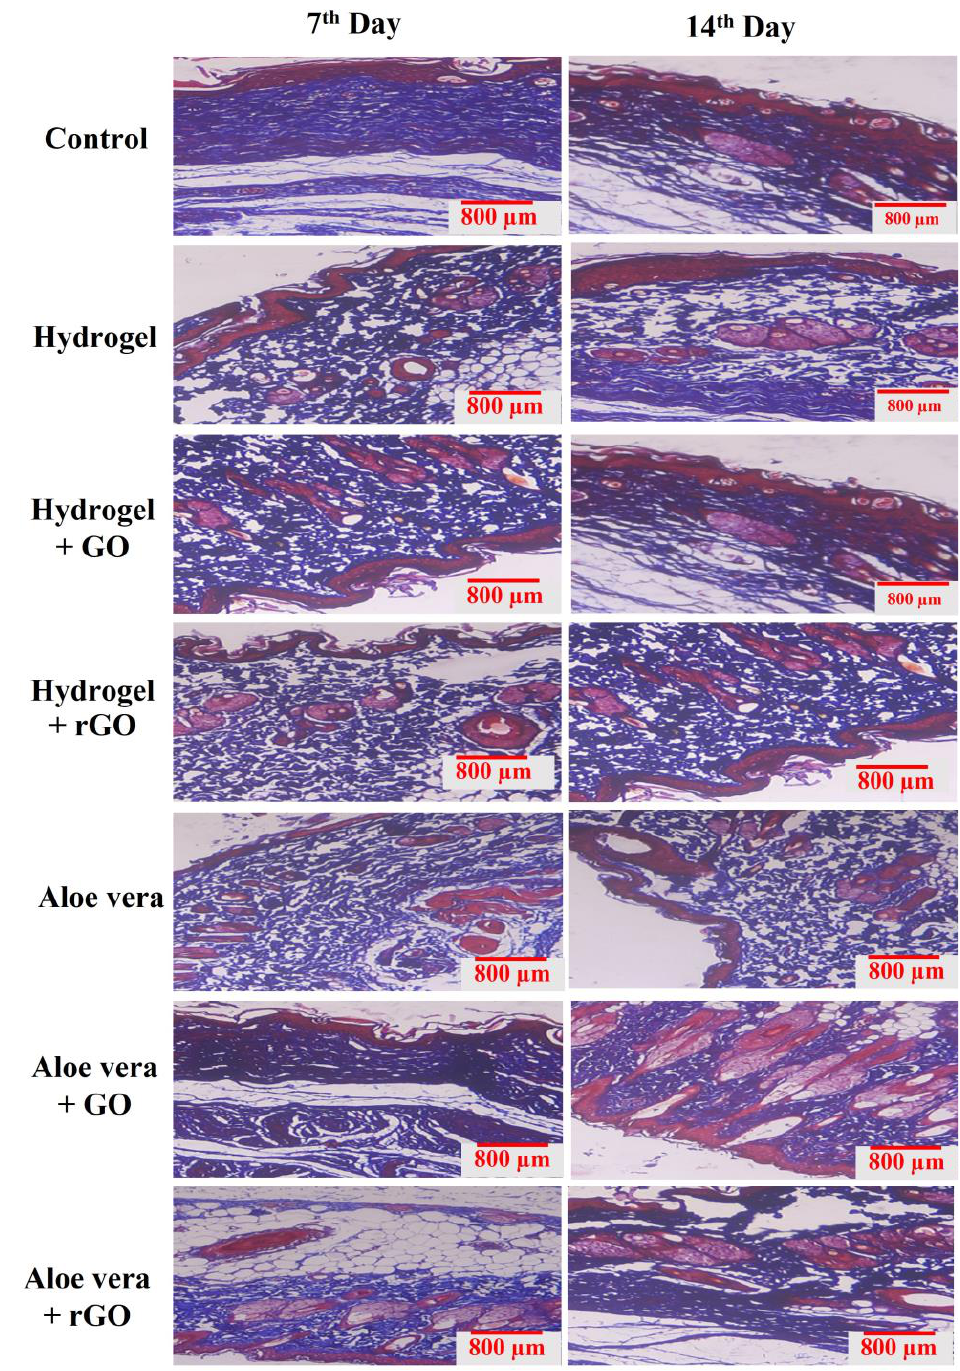
Figure 18. Masons trichome stained granulation tissues of GO and rGO-based composite gels on 7th and 15th days. The increased collagen deposition can be seen in the Masons trichome stained tissues of 14th day when compared to the 7th day.